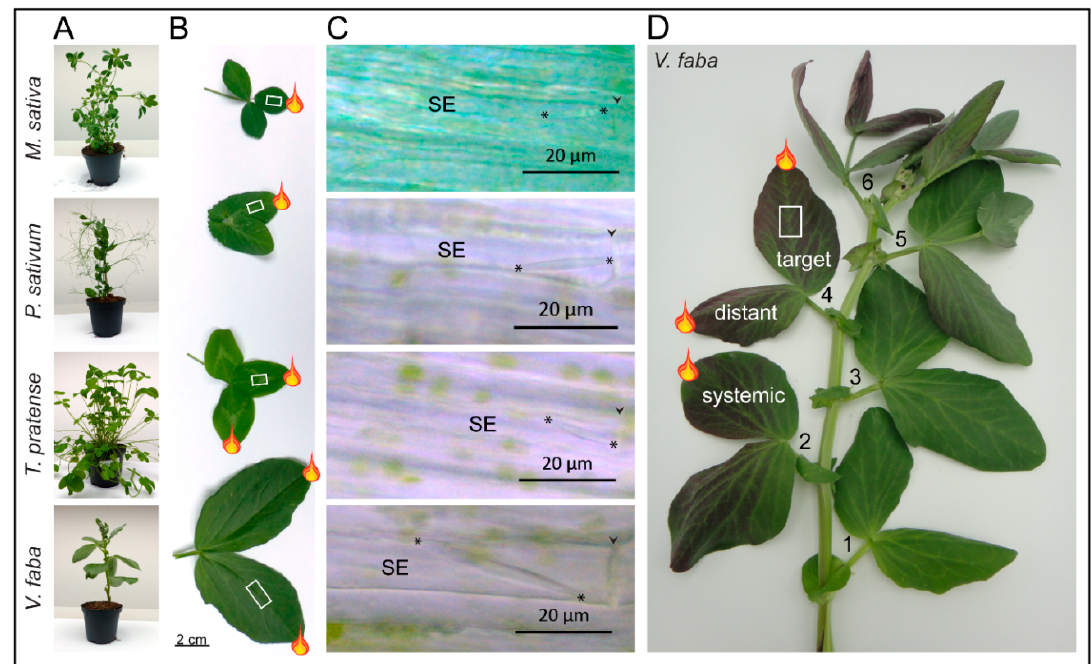
Figure 7. Overview of the plant species and experimental set-up. ( A ) Specimens of M. sativa , P. sativum , T. pratense and V. faba plants in use. The species possess compound leaves of various size and morphology (twin or triplet leaflets). ( B ) True to scale comparison of the respective leaves. The stimulated leaflets are labelled with a flame, the observation site is labelled with a white rectangle. ( C ) Micrographs of forisomes in the four legume species. Asterisks ( * ) indicate the forisome tips; arrow heads mark the location of a sieve plate. SE—Sieve element. ( D ) Detached V. faba plant stained with ink. One single incised stem section containing a major vascular bundle was submerged into an ink solution to illustrate the connectivity between leaves no. 2, 4 and 6. Mature leaves were numbered from oldest to youngest and leaf no. 4 was always used to cut the observation window (white rectangle). Flames indicate the different application sites of the heat stimulus.